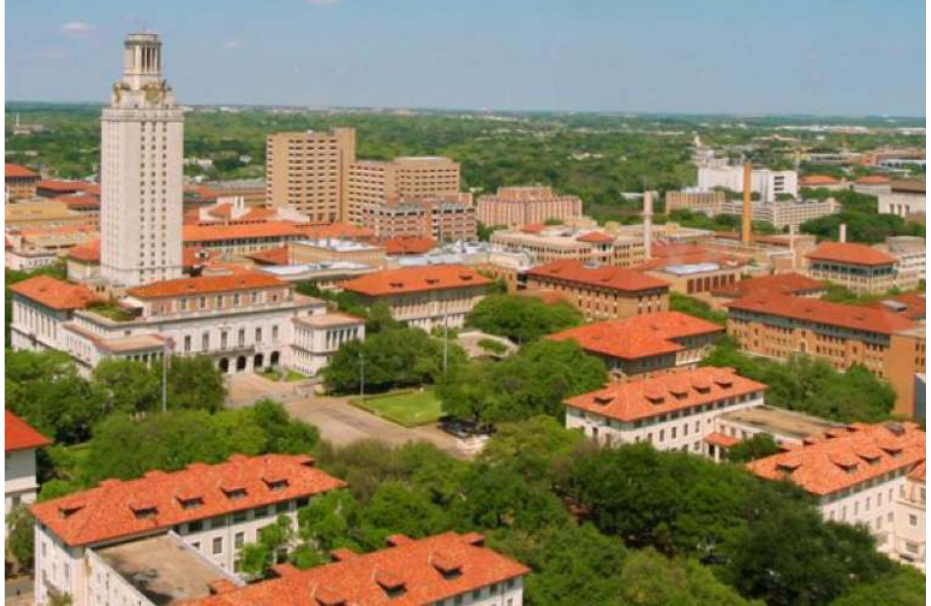
Source: https://news.utexas.edu/2017/05/04/bridging-barriers/